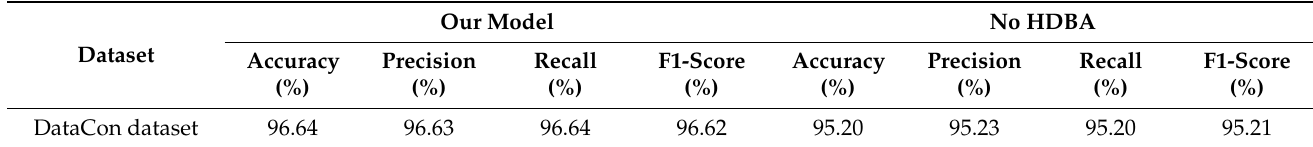
Table 11. The performance of our model on the Datacon data